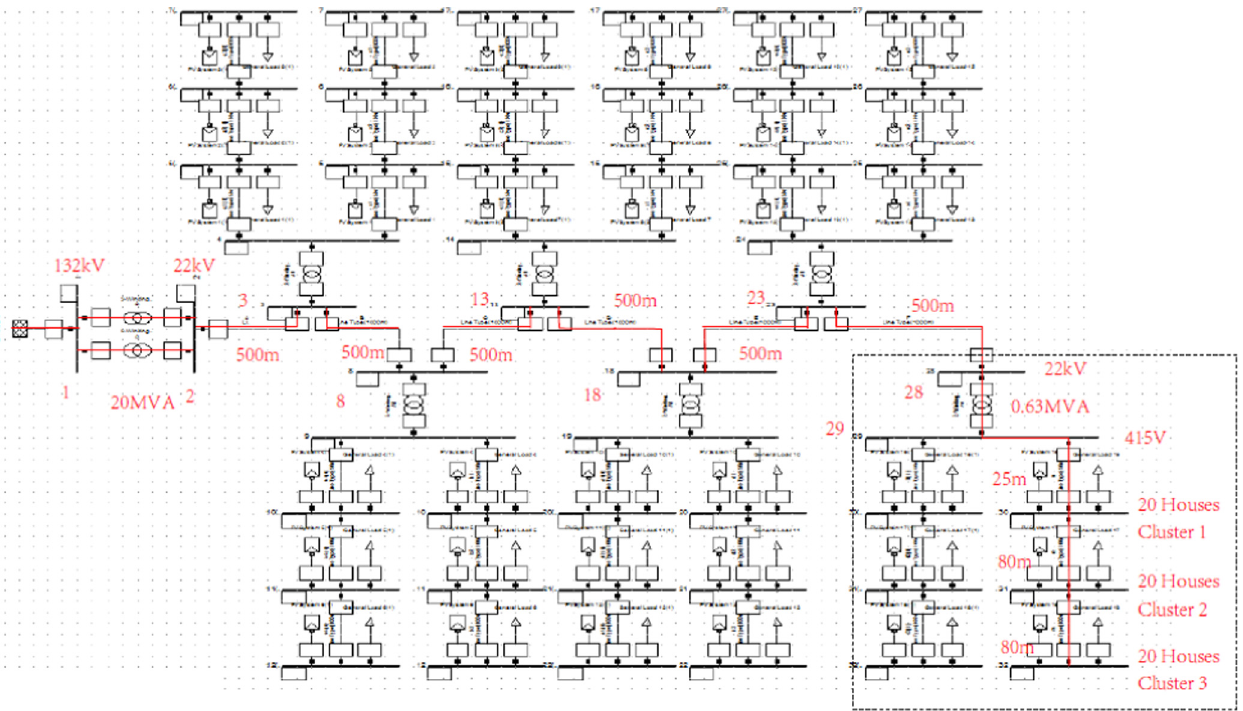
Fig. 1. PowerFactory model of the example 22 kV urban feeder with LV distribution